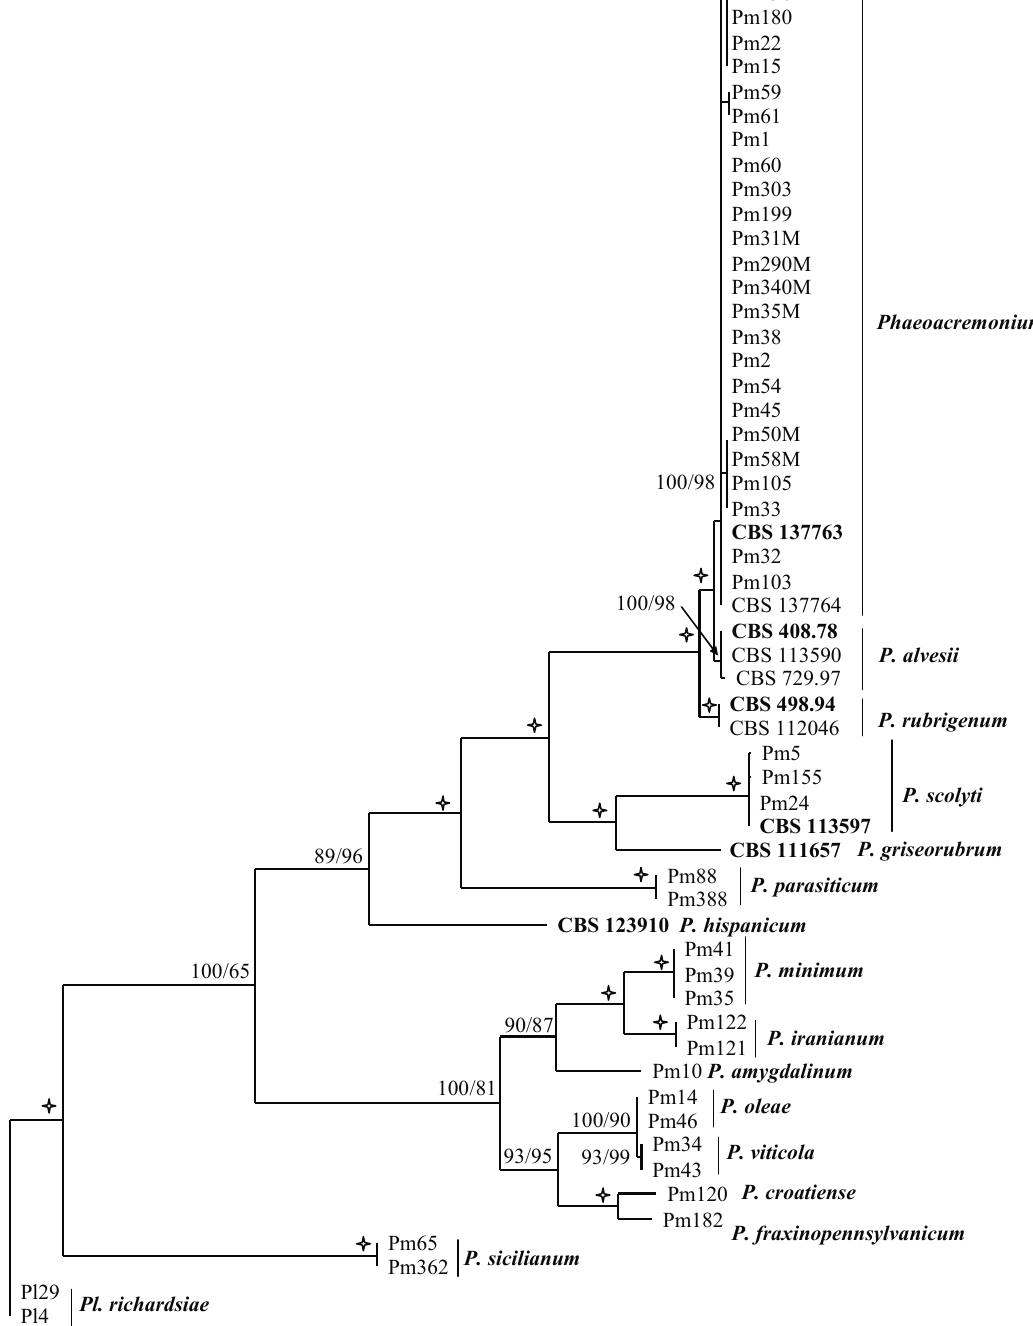
Figure 7. One of the 100 most-parsimonious trees obtained from alignment of the IGS sequences from Phaeoacremonium spp., with boot- strap values from 1000 replicates from maximum parsimony/maximum likelihood shown at the internodes. Bootstrap values of 100% are indicated with star symbols, and ex-type sequences are highlighted in bold. Pleurostoma richardsiae was included as an